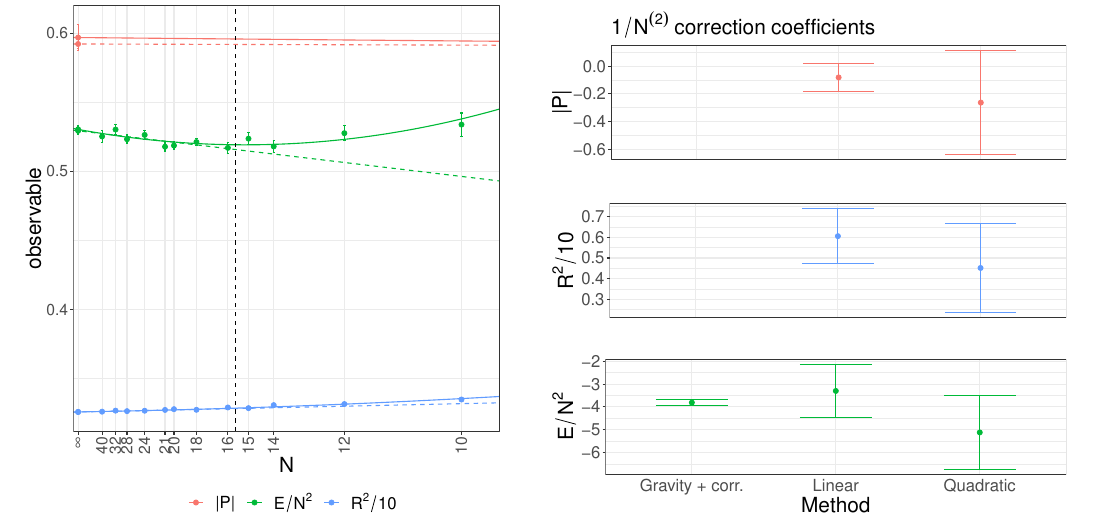
Figure 11 . [Left] Large- N extrapolation for T = 0 . 3 , L = 30 , µ = 0 . 5 . The first axis scales as 1 /N 2 . Solid lines are quadratic fits in 1 /N 2 . Dashed lines are linear fits in 1 /N 2 that use the data points at the left of the dashed black line. Due to the 1 /N scaling of corrections to | P | , the data points underlying the fit of | P | are outside of the plotting range. [Right] The coefficient ε 1 , 0 of the 1 /N 2 correction is obtained from the fit. These extrapolation ansätze lead to consistent extrapolation values. For the energy, we also show the gravity prediction obtained in [13], which includes a numerical estimate of the parameter b 1 from the fit of the BFSS model at T ≥ 0 . 4 . Error bars on the gravity result originate from uncertainties on the coefficient b 1 and don’t include an estimation of higher order